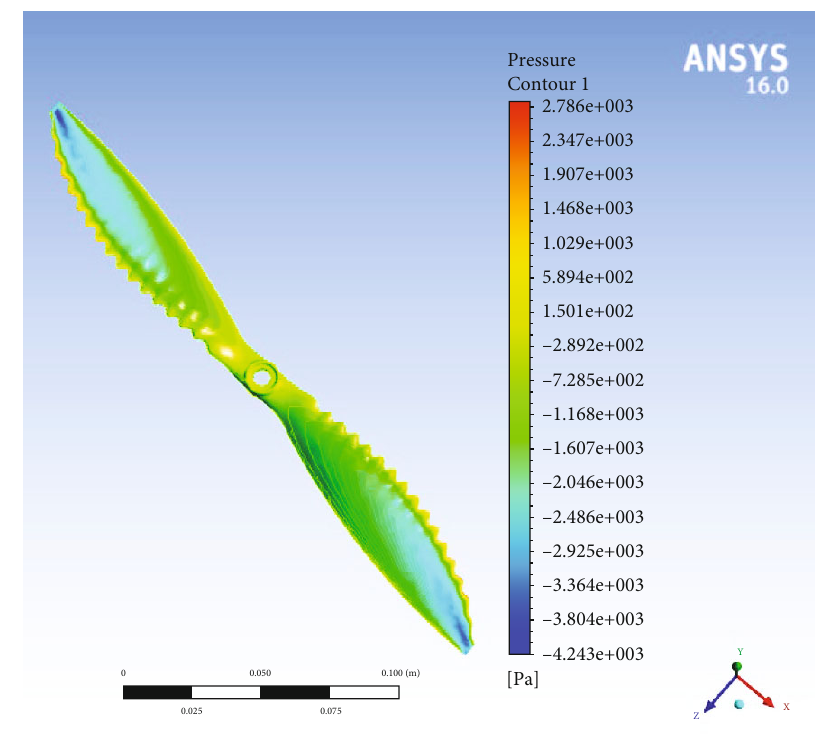
Figure 28: Pressure contour at -100 ° C